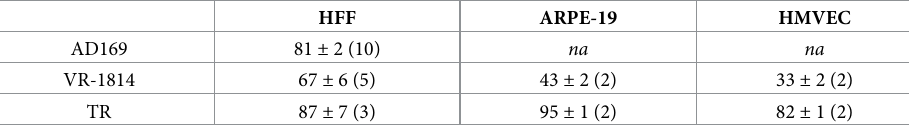
Table 1. Percentage of IE1/IE2+ cells.